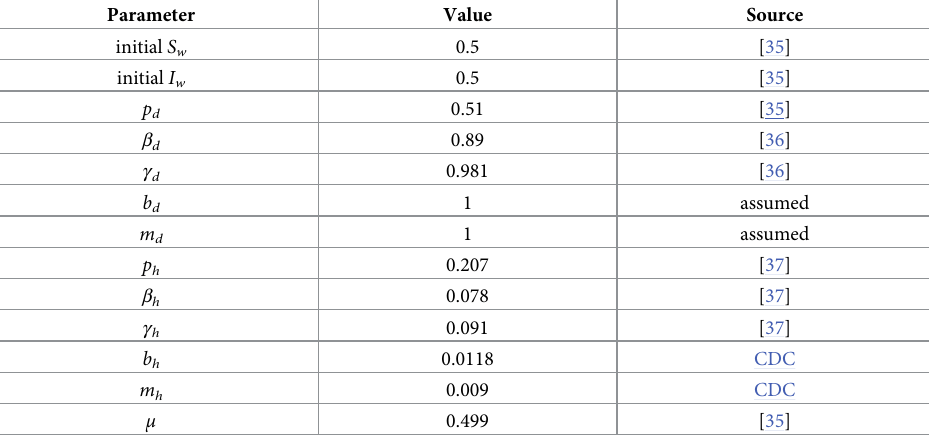
Table 5. Parameter values and sources for the model. Due to a lack of data for transmission parameters in wild animals, we assume β w , γ w , b w , and m w to be equivalent to their counterparts in domestic animals. The timesteps are given in